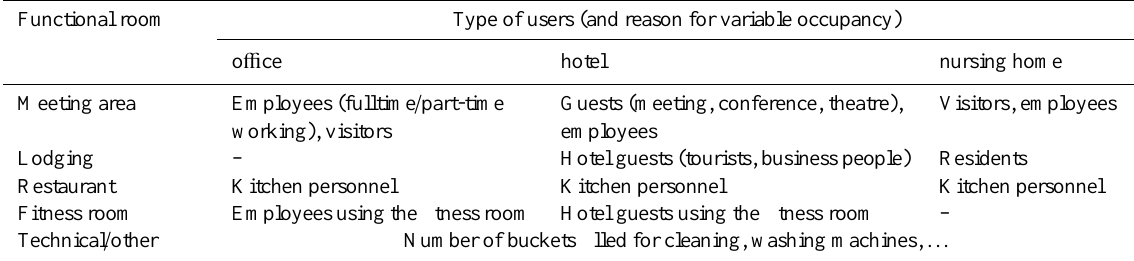
Table 2. Functional rooms and the type of user who take water in the functional rooms in three categories of non-residential buildings, o ffi ce, hotel and nursing